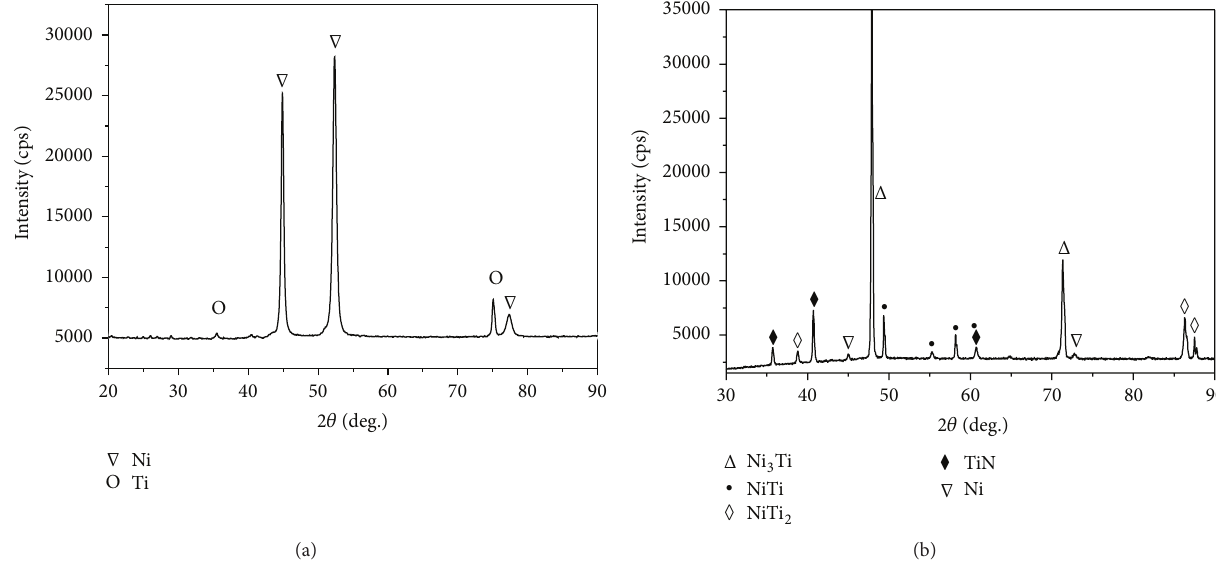
Figure 2: XRD patterns of Ni-Ti coatings (a) before and (b) after the heat treatment.